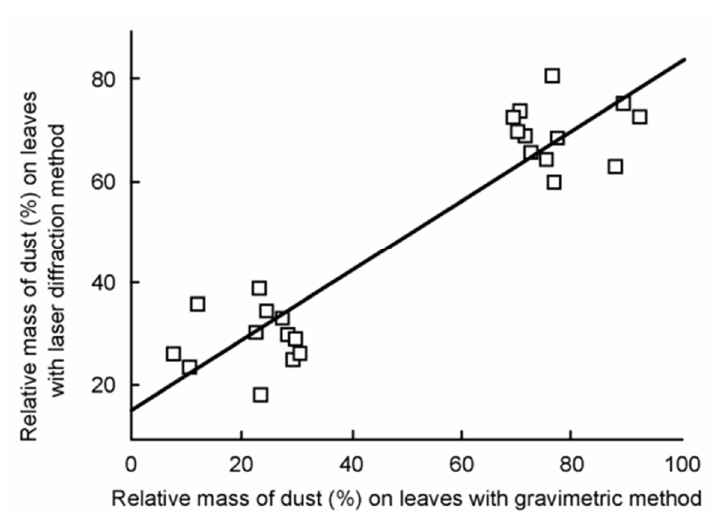
Figure 6. Scatter plot of the studied methods based on the concentration of PM on leaves. The regression line is also indicated.